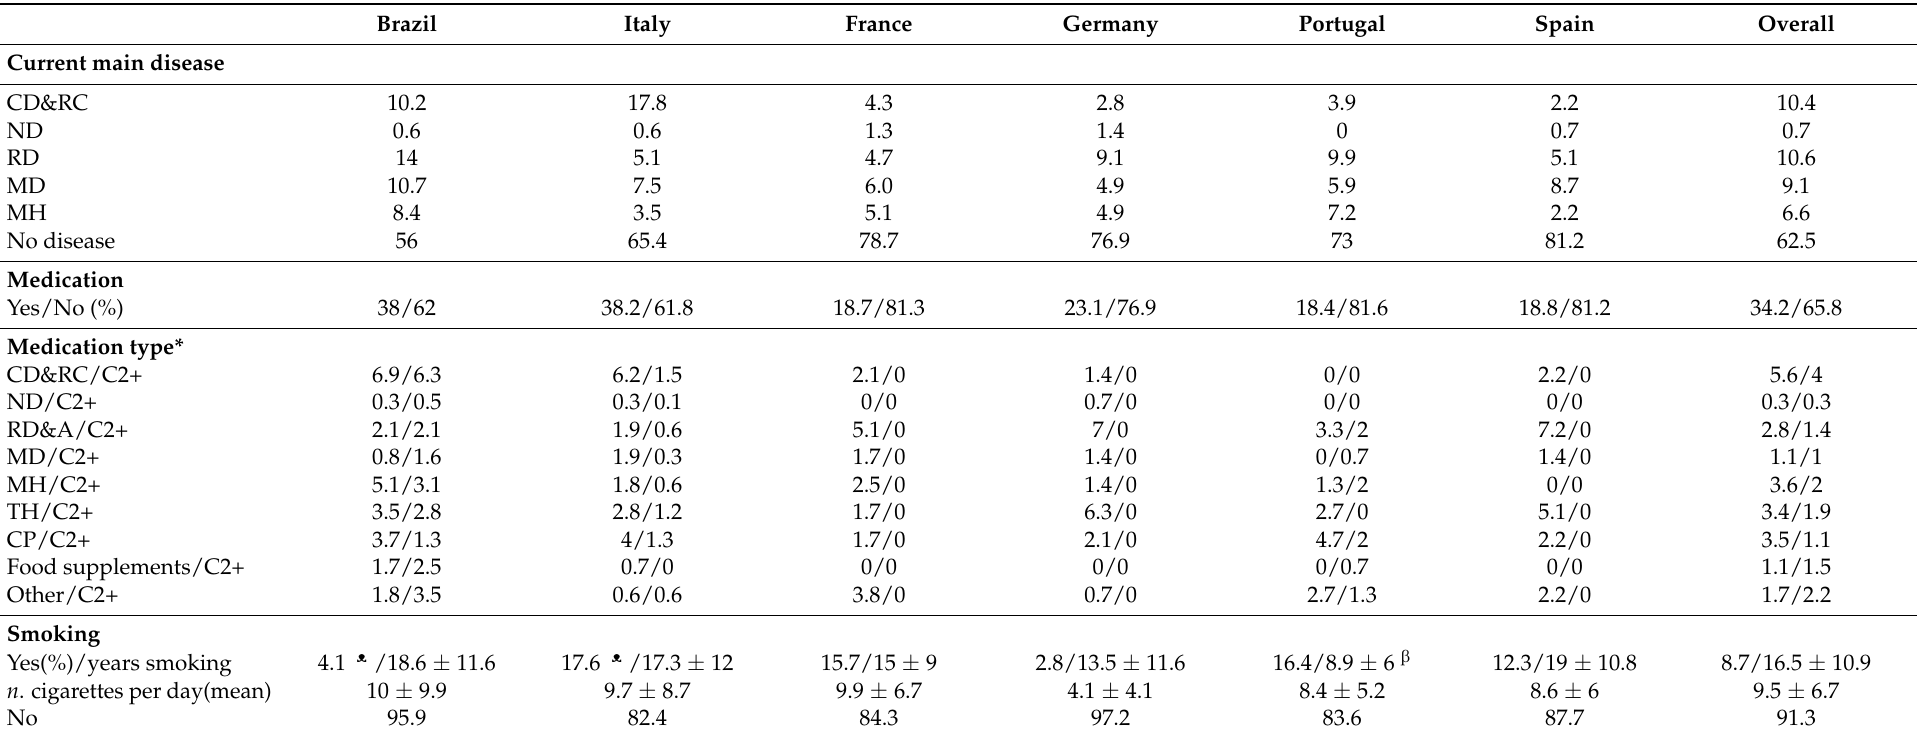
Table 3. Current health conditions of the sample from Brazil ( n = 1845), Italy ( n = 680), France ( n = 236), Germany ( n = 143), Portugal ( n = 152) and Spain ( n = 138), aged from 18 years old ( n = 2860). Values are presented as percentage (%).